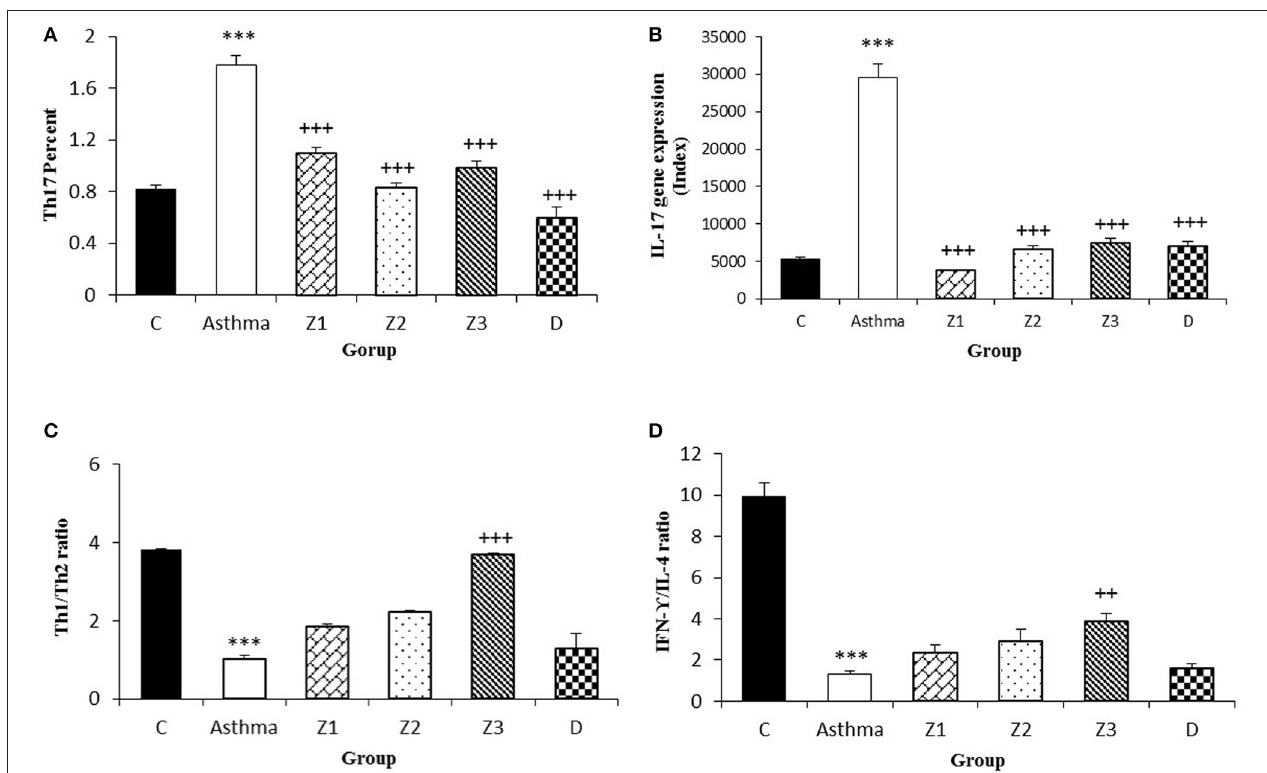
FIGURE 6 | Percent of Th 17 cells (A) , values of IL-17 gene expression (B) , Th 1 /Th 2 ratio (C) , and values of IFN- γ /IL-4 ratio (D) in splenocyte from control group (C, n = 5), Asthma group (A, n = 5) and A treated groups with the extract of Z. multiflora at concentrations 200, 400, and 800 µ g/mL (groups Z1, Z2, and Z3, respectively, n = 6) and dexamethasone (D, n = 5). Data were presented as mean ± SEM. *** p < 0.001, vs. control group. ++ p < 0.01, +++ p < 0.001, vs. asthma group. The statistical comparisons were made using ANOVA with Tukey–Kramer multiple post-hoc test.